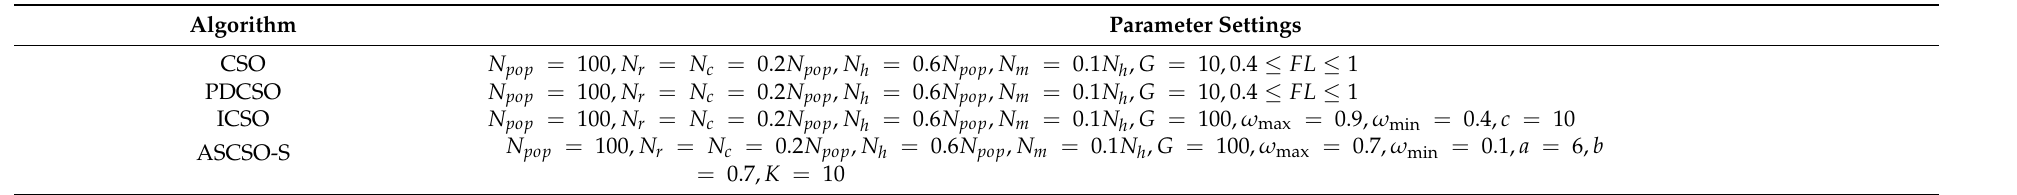
Table 2. Algorithm parameters. Algorithm Parameter